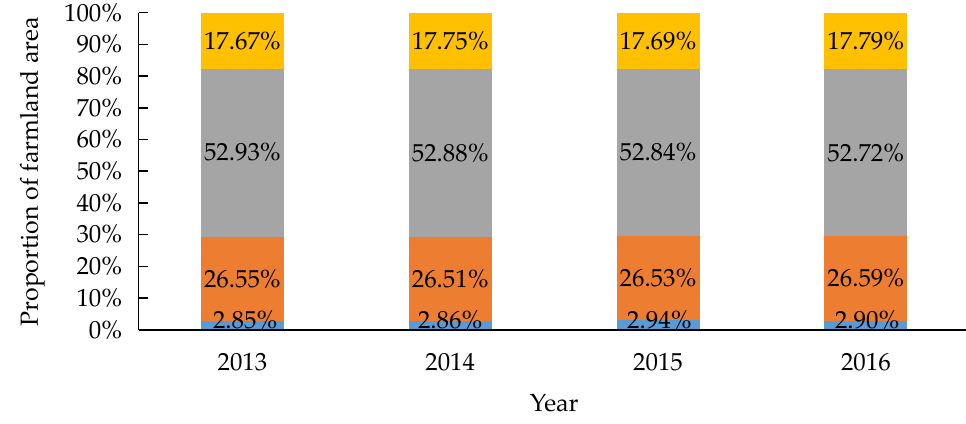
Figure 3. Changes in China’s farmland quality from 2013 to 2016 [67]. Notes: The Ministry of Natural Resources classified farmland in China into 15 grades based on comprehensive consideration of a variety of indicators, such as climate, terrain, soil, farmland infrastructure and land use. The quality of first-grade farmland is the best, and the quality of fifteenth-grade farmland is the worst. The farmlands of grades 1 to 4, 5 to 8, 9 to 12 and 13 to 15 are defined as the farmlands of superior grade, high grade, moderate grade and low grade, respectively.